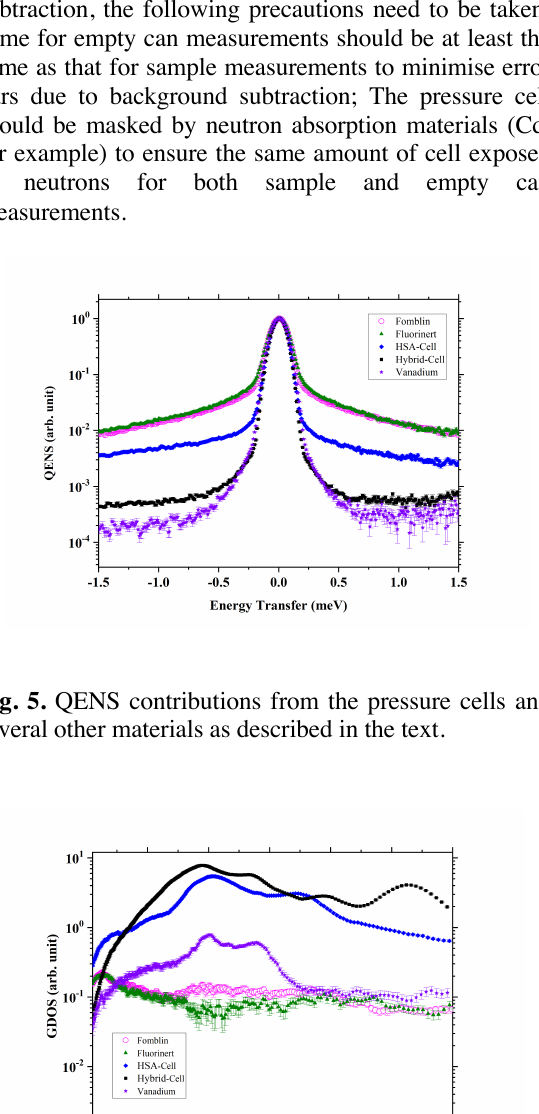
Fig. 6. GDOS from the pressure cells and several other materials as described in the